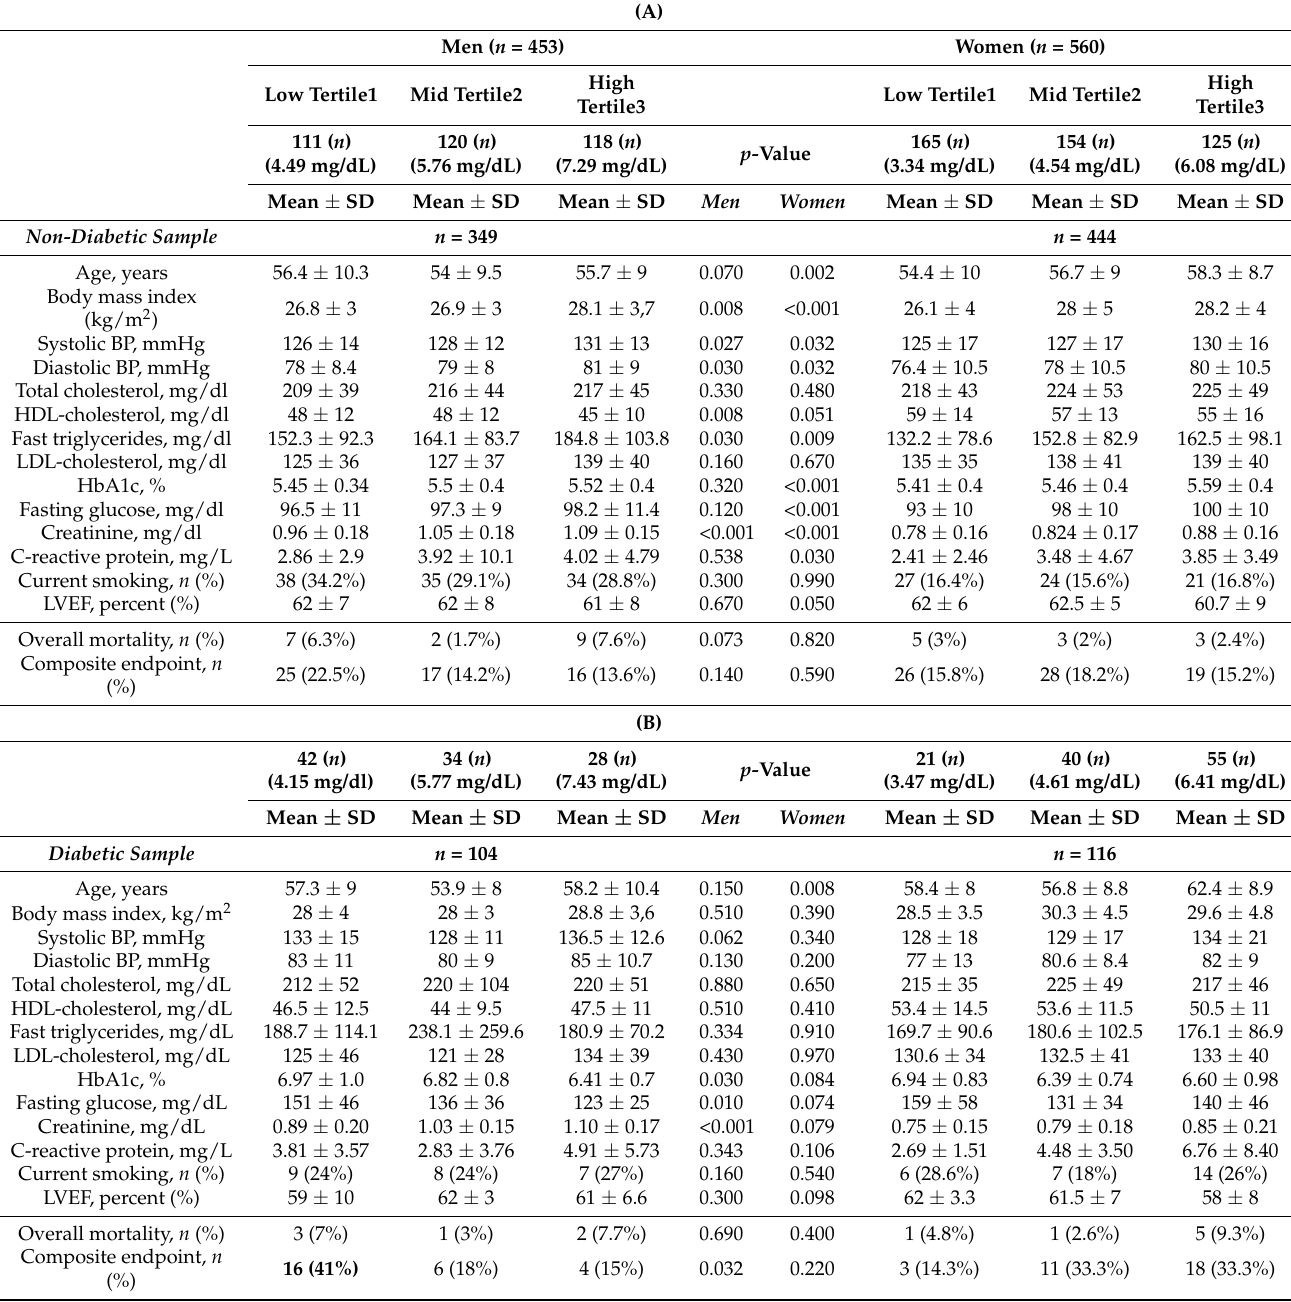
Table 1. ( A ) Characteristics of the study sample ( n = 1013), stratified to serum uric acid tertiles, gender, and non-diabetic group at baseline. ( B ) Characteristics of the study sample ( n = 1013), stratified to serum uric acid tertiles, gender, and presence of diabetes at